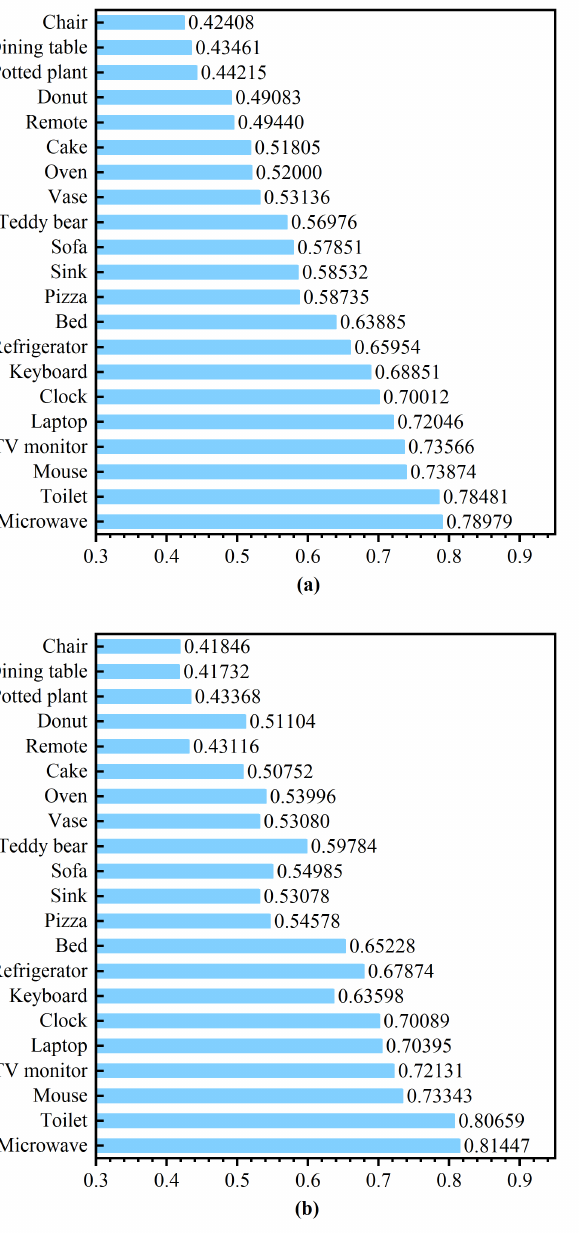
Figure 9. ( a ) Average precision without quantization and ( b ) average precision of partial quantization for different